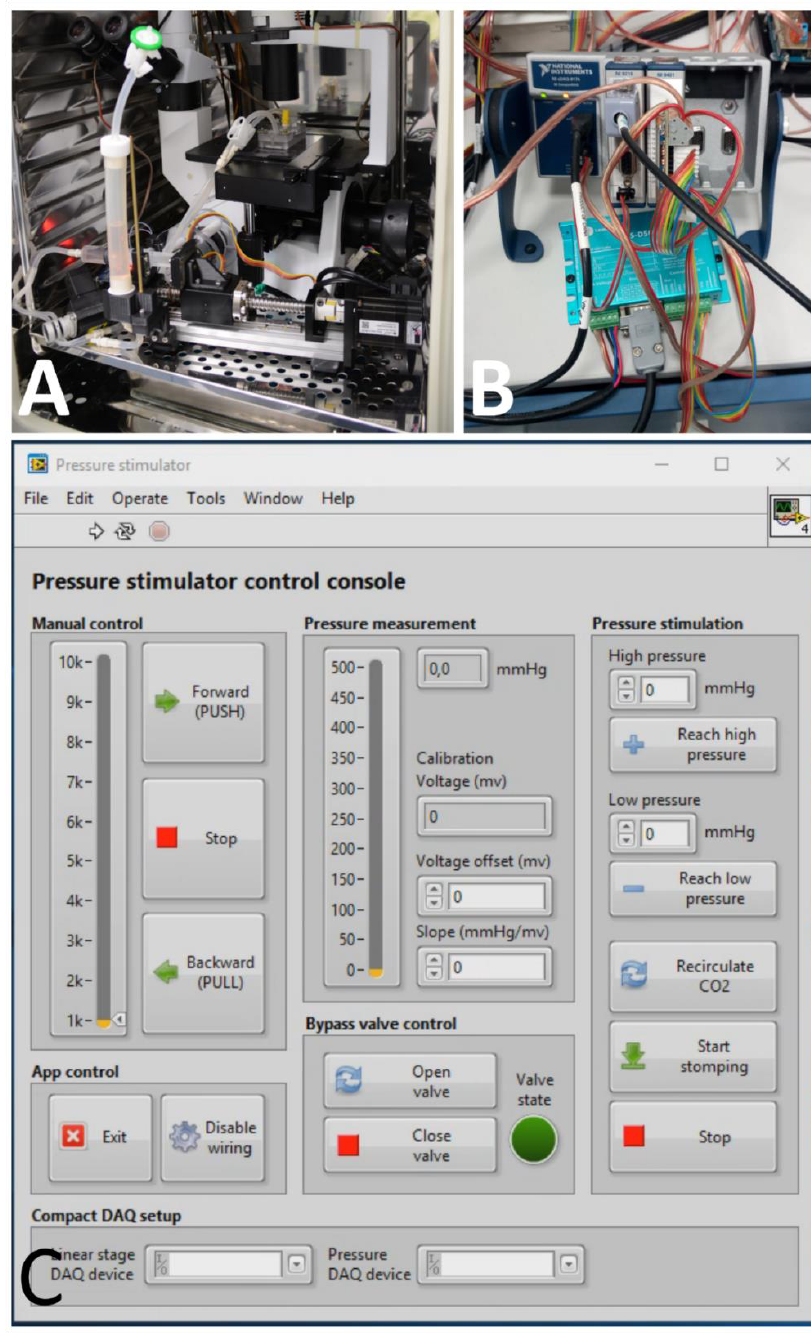
Figure 3. ( A ) The linear actuator with an installed syringe and working reservoir in a CO 2 cell incubator; ( B ) the compactDAQ control system; ( C ) the pressure stimulator controlling software GUI.